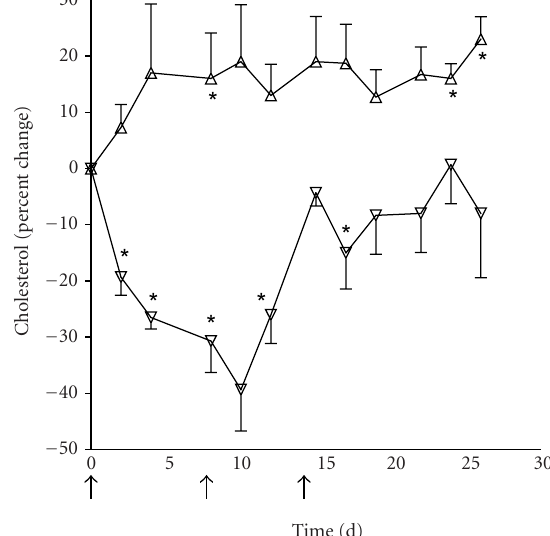
Figure 5. Average percent change in HDL ( ∆ ) and VLDL + LDL ( ∇ ) cholesterol concentrations in baboons after intravenous in- jections of the truncated apoC-I peptide at 10, 15, and 20mg/kg on days 0, 7, and 14, respectively (arrows). The baboons were fed the HCHF diet. Values are expressed as mean ± SE, n = 3. Values significantly di ff erent from those at day 0 are marked by an asterisk ( P < . 05).